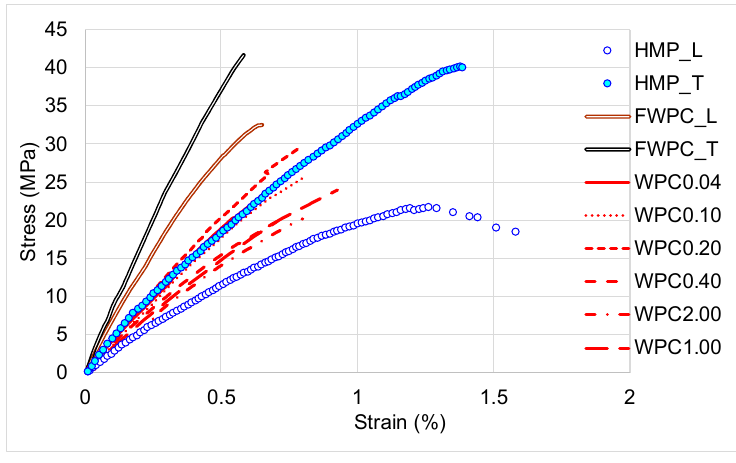
Figure 7. Comparison of stress–strain curves for tested samples.